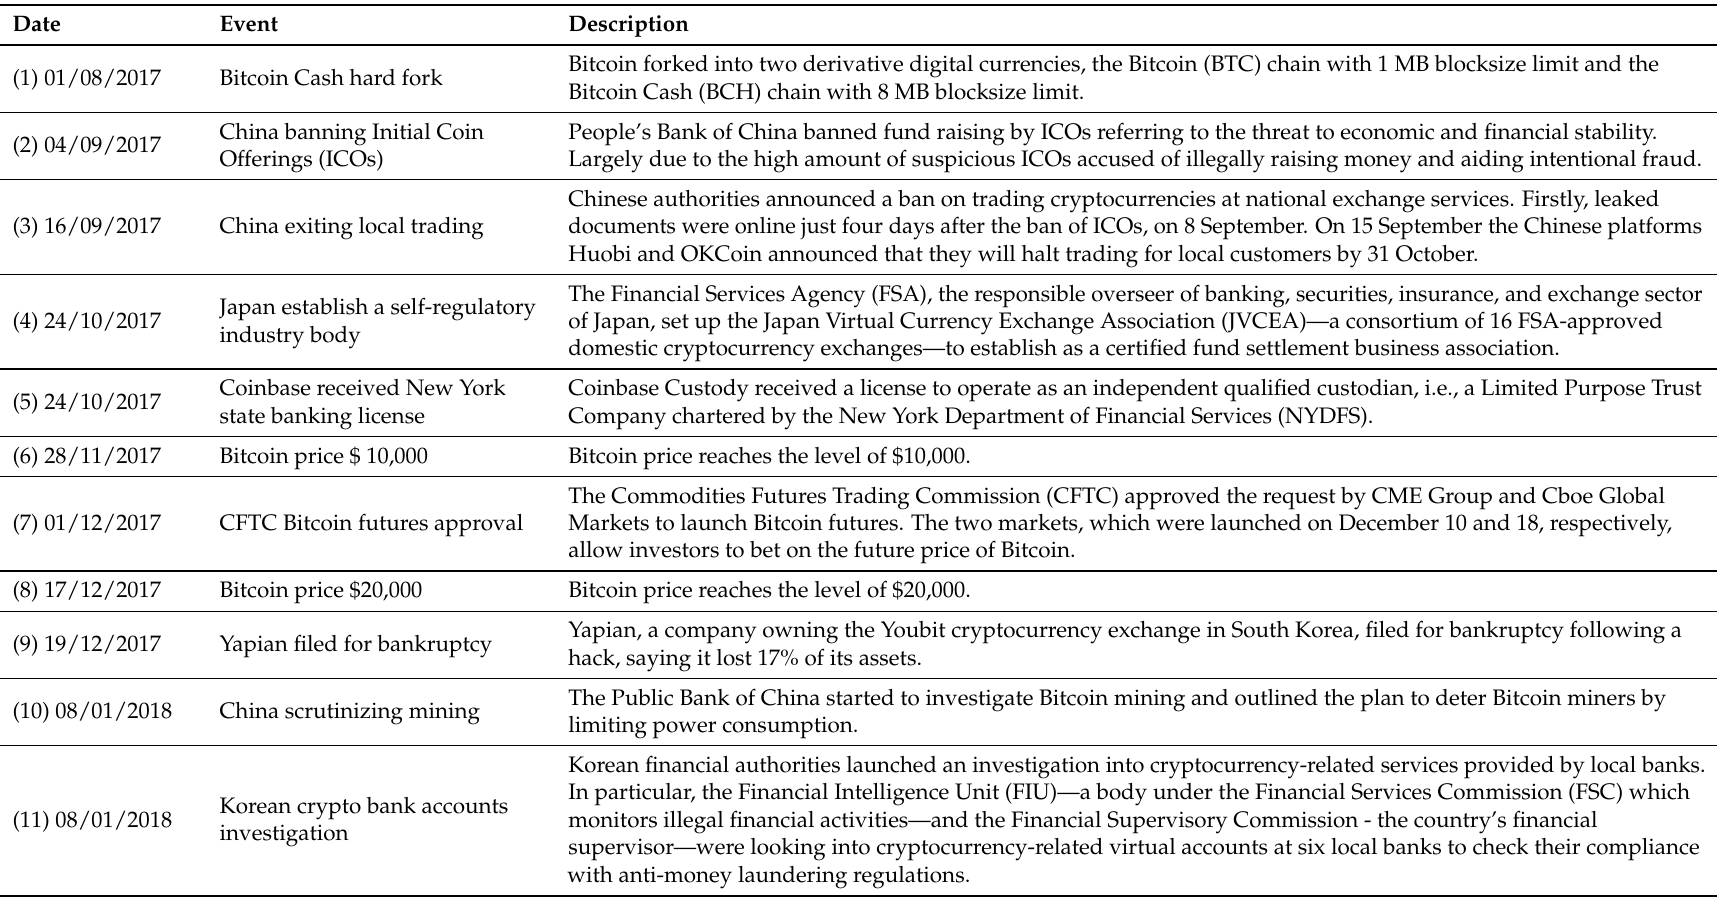
Table 1. Main events related to